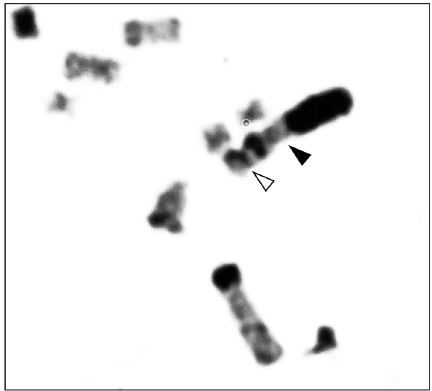
Figure 4 - A chromosome association between SM1 (closed arrow) and a small metacentric autosome (open arrow) shown in a metaphase plate of M. stejnegeri